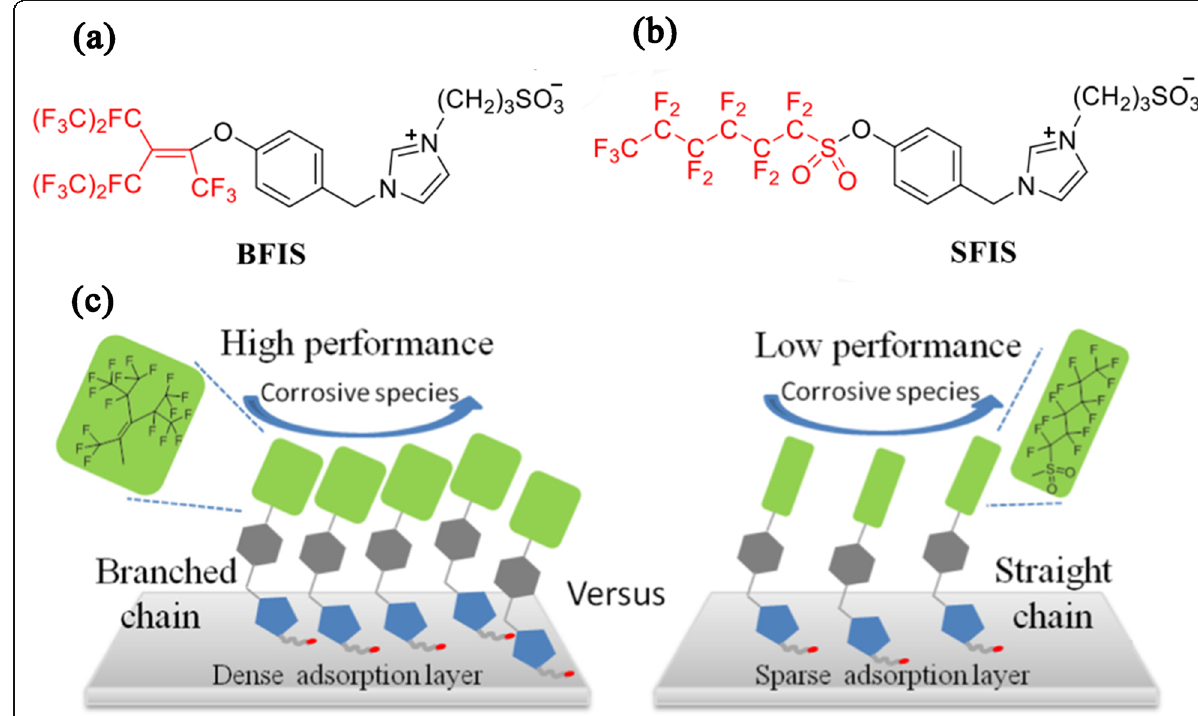
Fig. 4 Chemical structure of BFIS ( a ) and SFIS ( b ); Adsorption behavior and corrosion inhibition mechanism of BFIS and SFIS ( c ) [89].